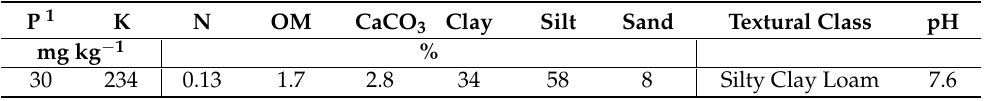
Figure 1. ( a ) Bare soil image with superimposed elevation contours and soil sample locations. Dark colored areas are unfarmed exposed bedrock, and ( b ) irrigation treatments for the 2017 growing season. GSP = grower’s standard practice, High = 1.3 ∗ GSP rate, Low = 0.7 ∗ GSP rate, and Zero = no irrigation. Small squares are the paired t -test plots used to compare yields across irrigation treatments. Table 1. Field average topsoil test results (0–30 mm).